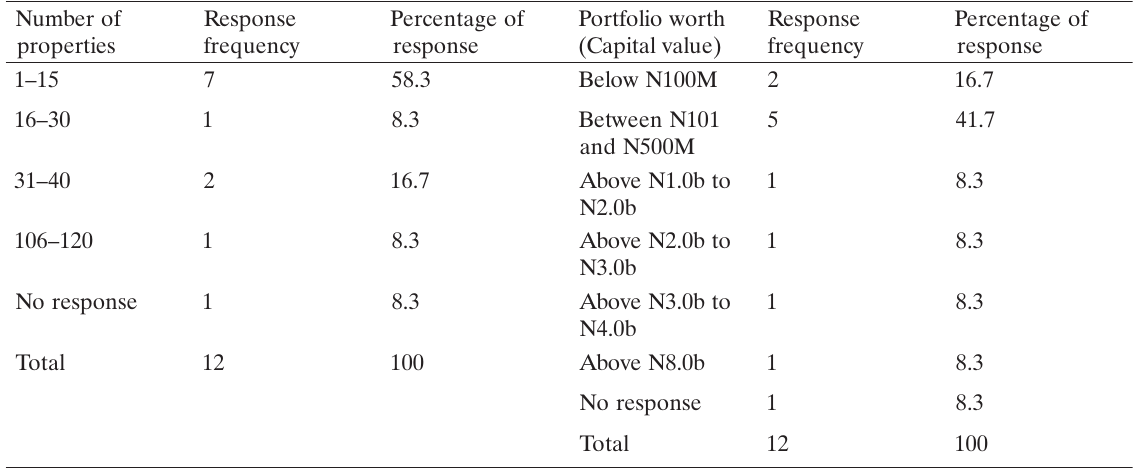
Table 3. Average number of properties in investors’ portfolios and the portfolios’ value forebmuN